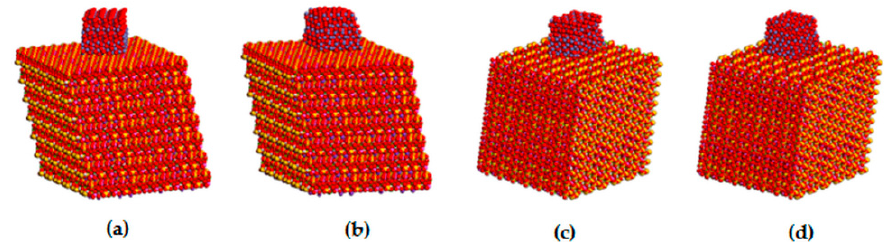
Figure 5. Optimized structure models of: ( a ) α -Fe 2 O 3 (012) / VER(001), ( b ) α -Fe 2 O 3 (104) / VER(001), ( c ) α -Fe 2 O 3 (012) / VER(100), and ( d ) α -Fe 2 O 3 (104) / VER(100).